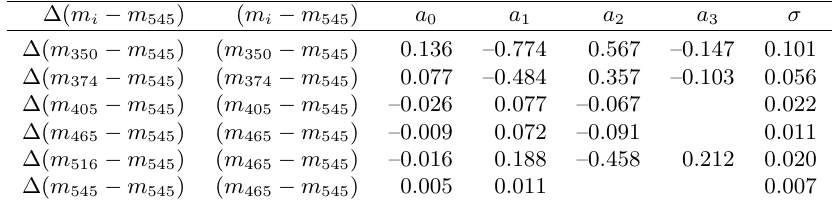
Table 1. Coefficients of Equation (2) and the accuracy of the decontamination corrections (cid:27) for six passbands constructed from the simulated Gaia BP spectra (with M stars, without